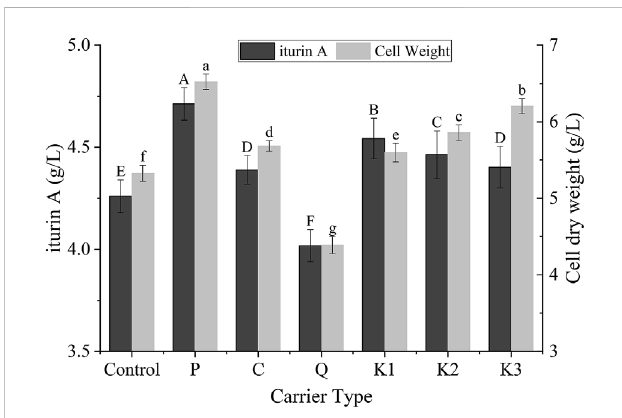
Effectsofdifferentcarriersonthecellgrowthandtheproductionof iturin A in B. velezensis ND in the shake- fl ask scale. Different letters meant there was signi fi cant difference among groups ( p <